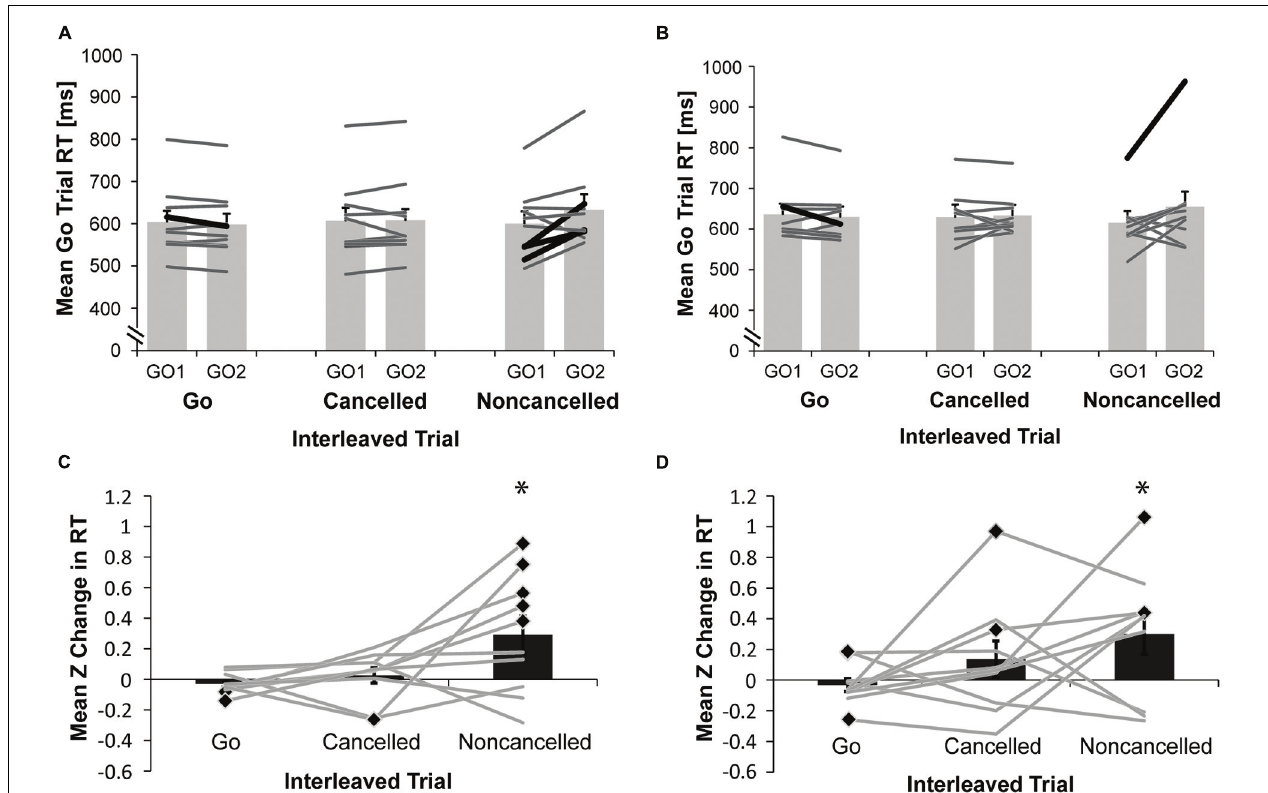
FIGURE 4 | Adaptive RT adjustments. (A,B) Light gray bars compare mean ± SEM go trial RT for sets of three consecutive trials where go trials immediately preceded (GO1) and followed (GO2) either a correct go, a canceled stop or a non-canceled stop interleaved trial, for rats ( N = 10) performing the countermanding task at (A) 7 months of age or (B) 12 months of age. Heavy black lines show individual animal mean RTs where GO1 and GO2 were significantly different (paired t -test, p < 0.05) whereas dark gray lines show individual animal mean RTs where GO1 and GO2 were not significantly different. (C,D) Dark gray bars show mean ( ± SEM) Z change in go trial RT for trials following, compared to trials preceding, an interleaved correct go, canceled stop or non-canceled stop trial for rats ( N = 10) at (C) 7 months of age; or (D) 12 months of age, where Z = [GO2RT(trial) – GO1RT(mean)]/GO1RT(standard deviation). Light gray lines represent Z scores for each individual animal at each interleaved trial type ( ∗ significant difference of mean Z score from zero with one-sample t -test, p < = 0.05; black diamonds indicate significant difference of an individual animals Z score from zero with a one-sample t -test, p <